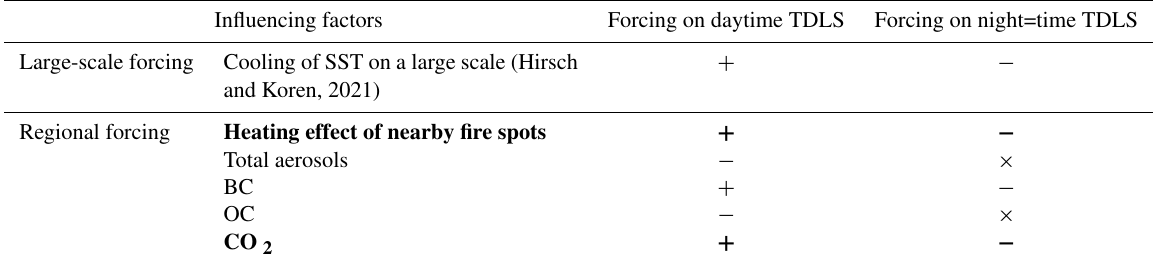
Table 2. Summary of the effect of different factors on TDLS. Factors marked in bold represent that they are either a weak factor or a potential factor derived from theoretical analysis but not verified by observation.